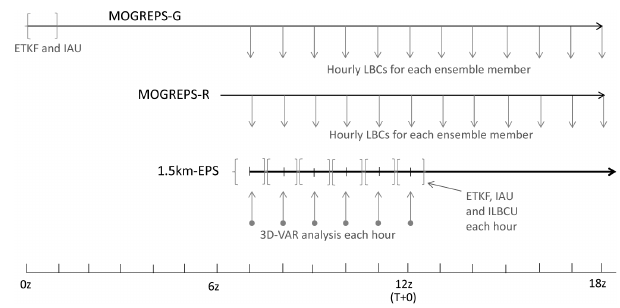
Fig. 2. Schematic diagram showing the model setup of the 1.5km EPS used in this study. Times shown are for 20 September 2011.